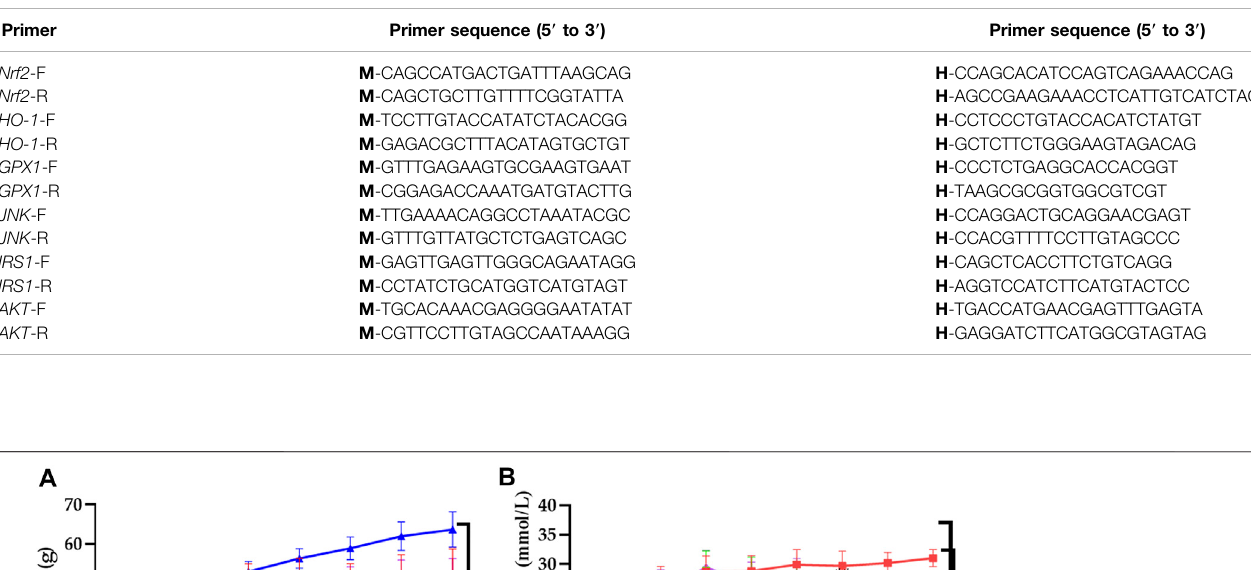
TABLE 1 | The qPCR primer sequences.